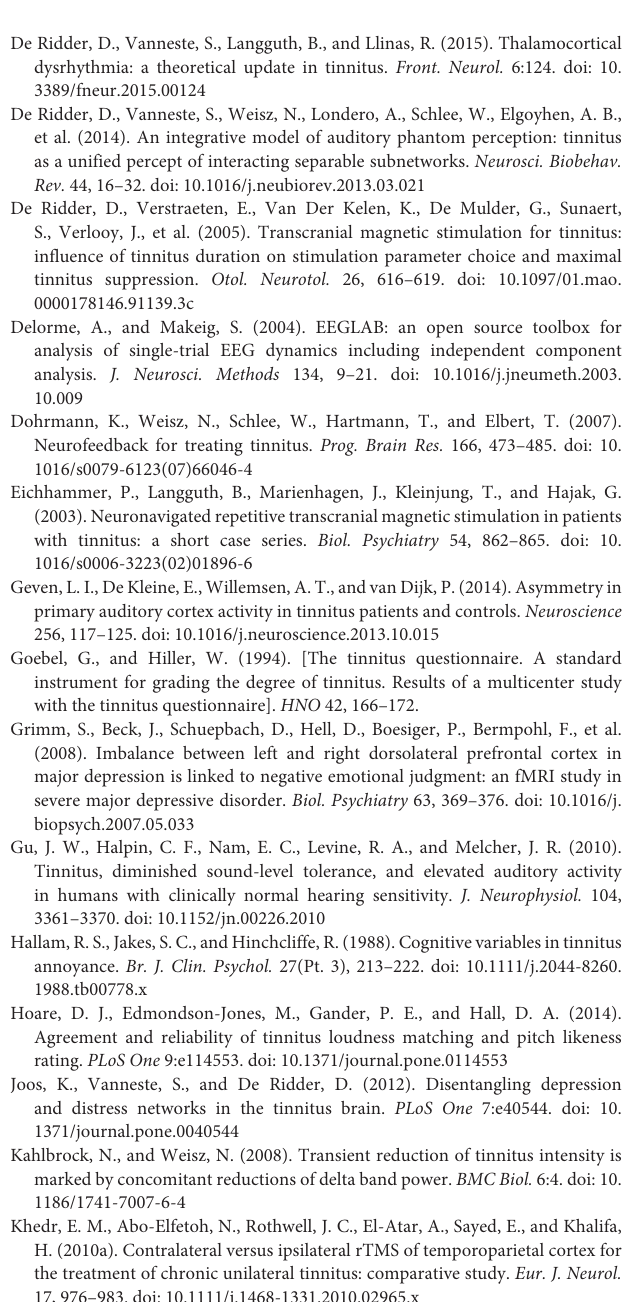
Supplementary Figure 1 | EEG power ( µ V 2 ) for the group of healthy